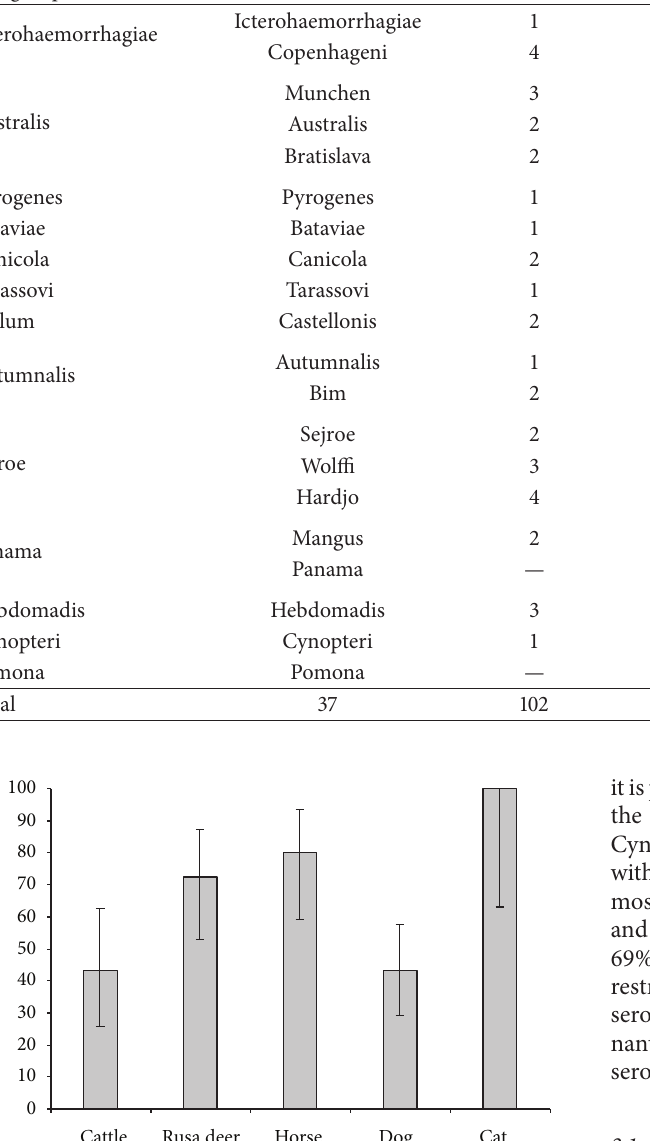
Table 1: Results of positive MAT according to pathogenic leptospiral serovars in different animal species (only reactive serovars are listed). Serogroup